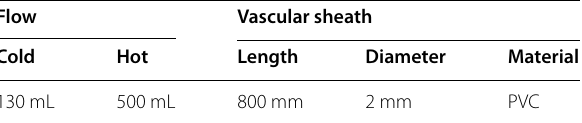
Table 3 Experimental